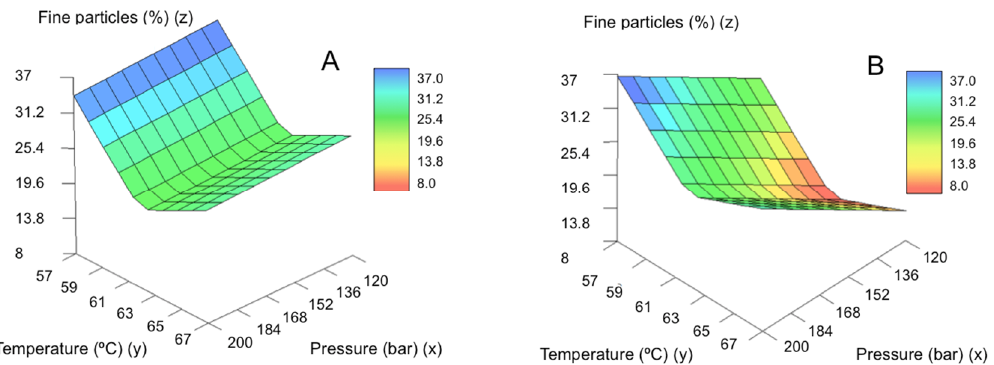
Figure 6. Influence of the parameters pressure and temperature on the yield of fine particle formation using: ( A ) the large nozzle diameter and ( B ) the smaller nozzle diameter.